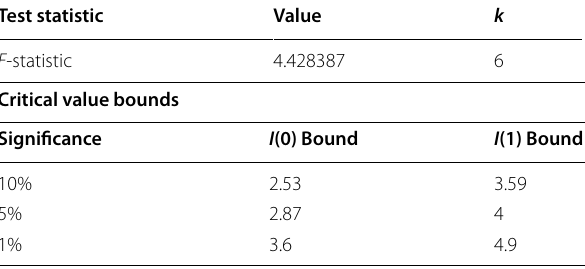
Table 5 Bound test for cointegration. Source : Computed by the Researchers, 2017 Test